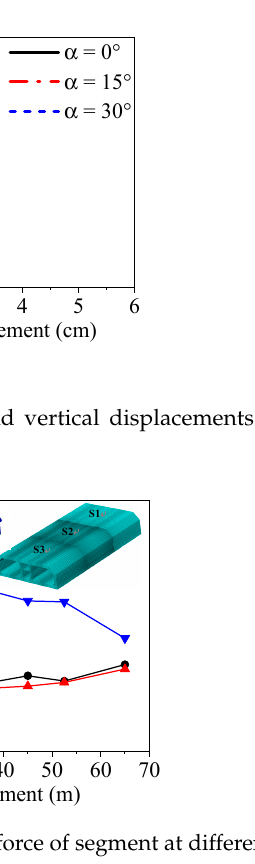
( b ) Figure 17. Horizontal and vertical displacements of segment at different angles of incidence: ( a ) horizontal; ( b ) vertical. 4.3. Internal Force of Immersed Tunnel